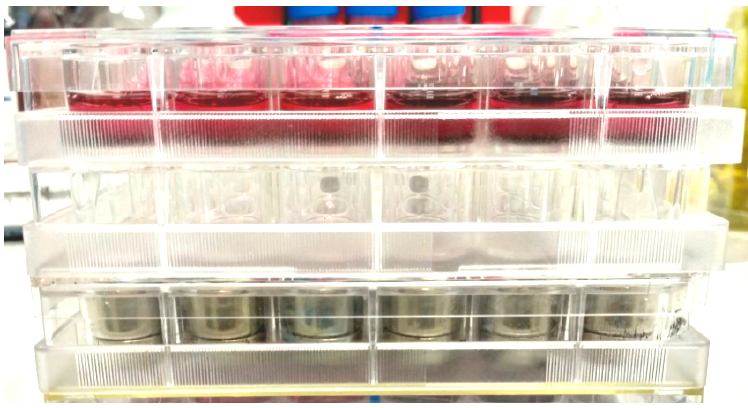
Figure 4. Arrangement of the cellular experiments with the use of plates’ stack. See explanation in text.